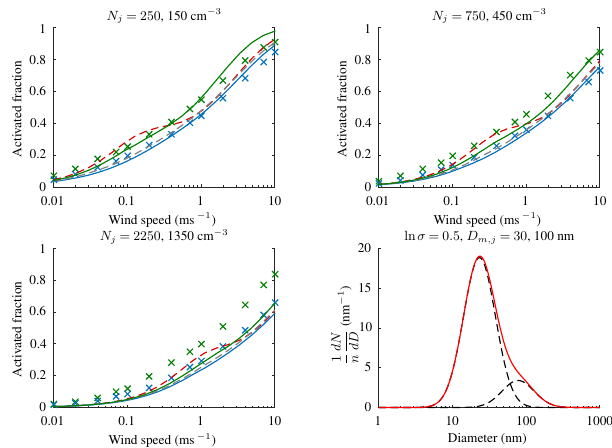
Figure 4. Same as Fig. 3 but with a different size distribution.